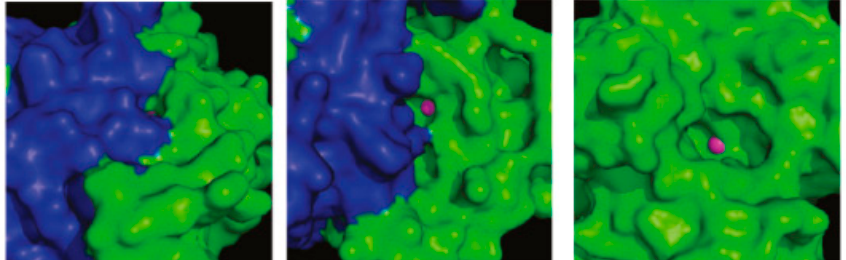
Figure 23. Comparison of accessible surface volumes of the active sites of M. tuberculosis Rv1284 (left,